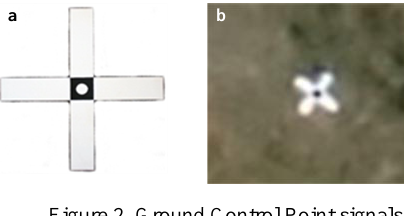
Figure 2. Ground Control Point